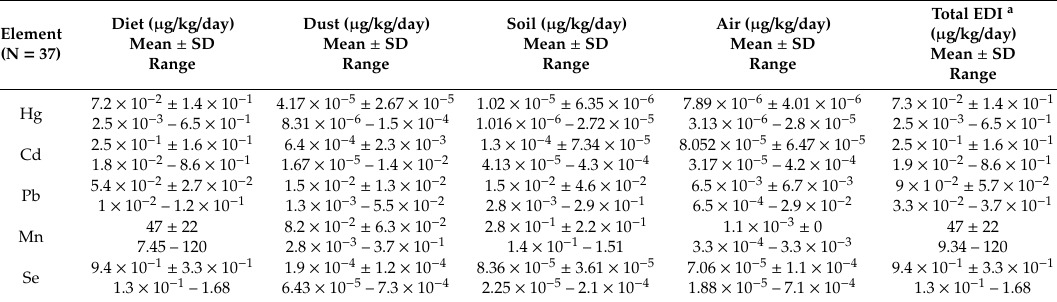
Table 6. Estimated daily intake of five